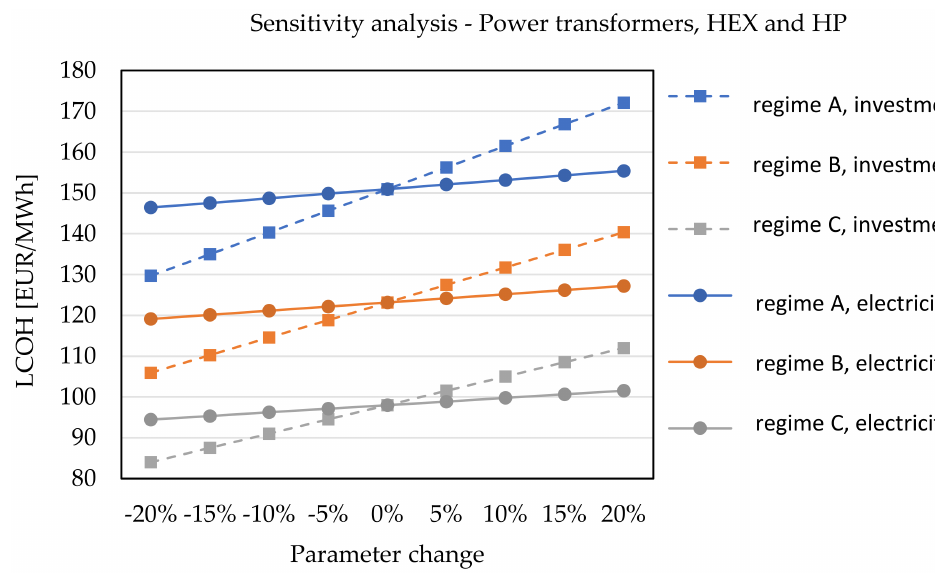
Figure 26. Sensitivity analysis for different DH network temperature regimes—power substation waste heat, utilization technology heat exchanger and heat